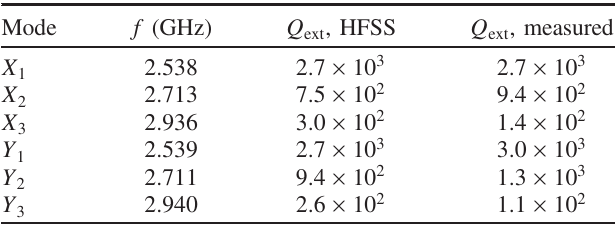
TABLE V. Comparison between simulated and measured ex- ternal Q factors for six of the dangerous HOMs.